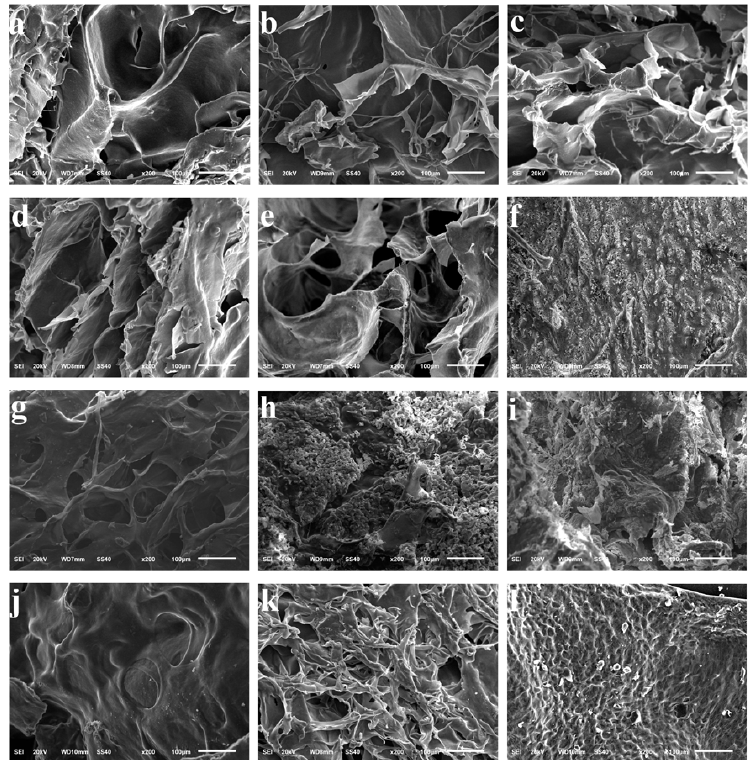
Figure 5. Microstructure of LRS/KGM mixtures in acid or salt solutions at pH 7 ( a ), pH 3 ( b ), without salts ( c ), 0.1 mol/L NaCl ( d ), 0.5 mol/L NaCl ( e ), 1.0 mol/L NaCl ( f ), 0.1 mol/L KCl ( g ), 0.5 mol/L KCl ( h ), 1.0 mol/L KCl ( i ), 0.1 mol/L CaCl 2 ( j ), 0.5 mol/L CaCl 2 ( k ) and 1.0 mol/L CaCl 2 ( l